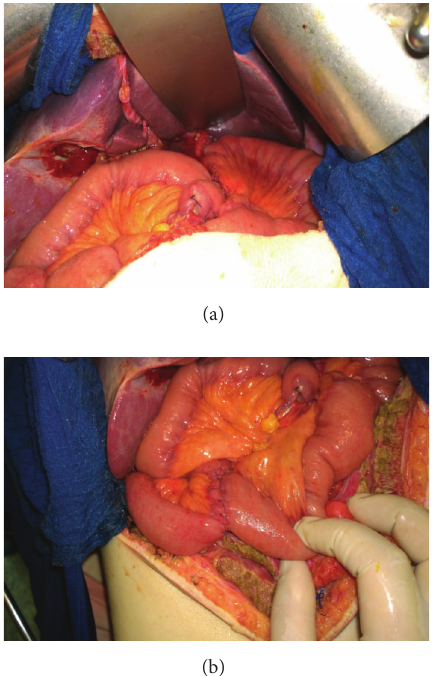
Figure 2: (a) and (b) show esophagojejunal anastomosis, hepatico- jejunal, pancreaticojejunal, and jejunojejunal